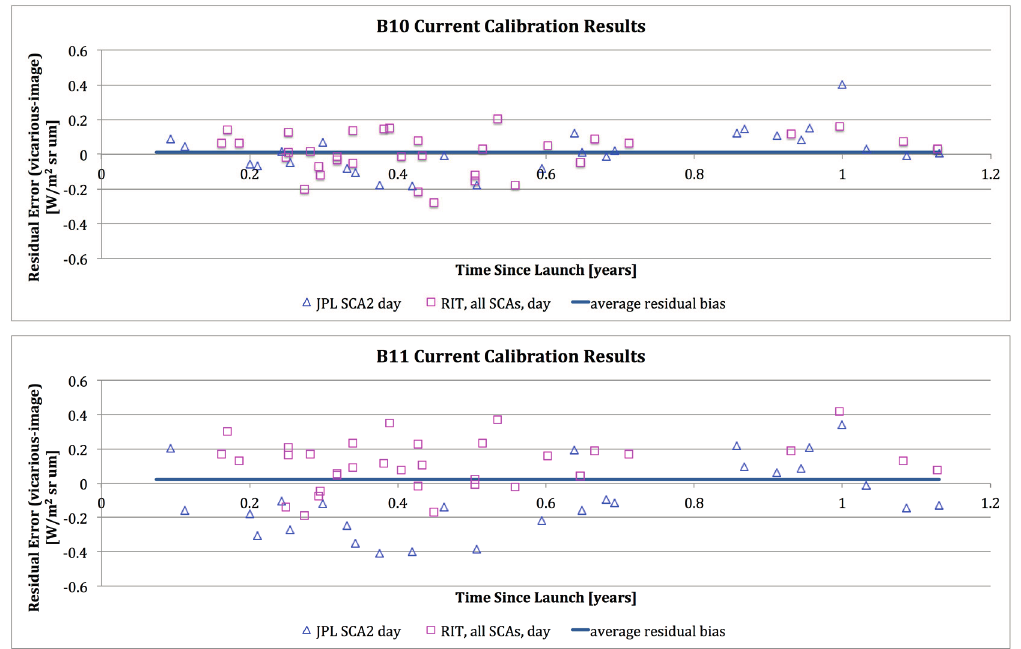
Figure 15. Current vicarious calibration results for the two TIRS bands over time. The residual difference between the vicarious radiance and the image radiance is scattered about the zero